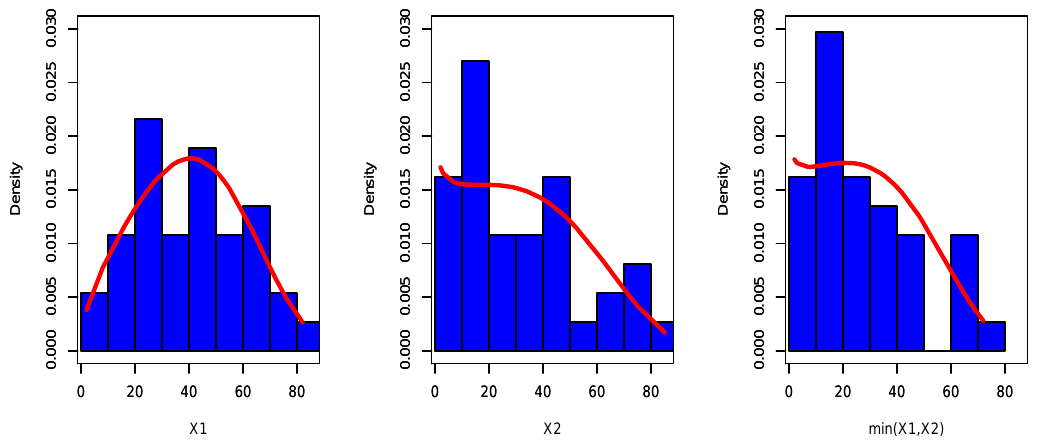
Figure 5. The fitted PDF for X 1 , X 2 and min ( X 1 , X 2 ) for data set I.